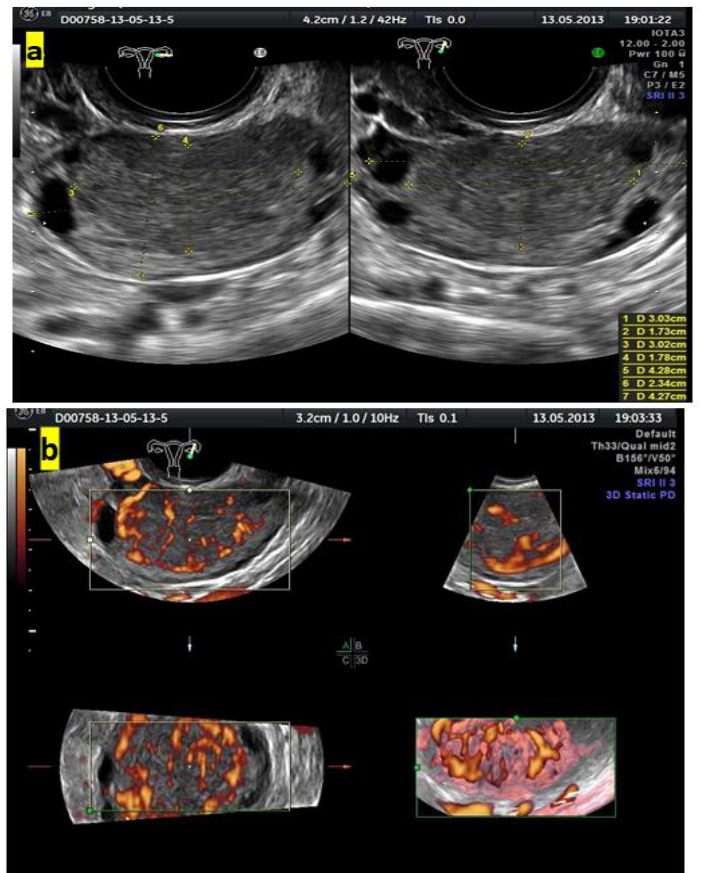
Figure 4. ( a ) Grayscale imaging of two perpendicular sections of a small, oval ovarian lesion resem- bling “ground-glass” echogenicity. ( b ) Central vascularization (color score, 4) seen in 3 perpendicular planes on color Doppler 3D sonography indicates a solid mass.